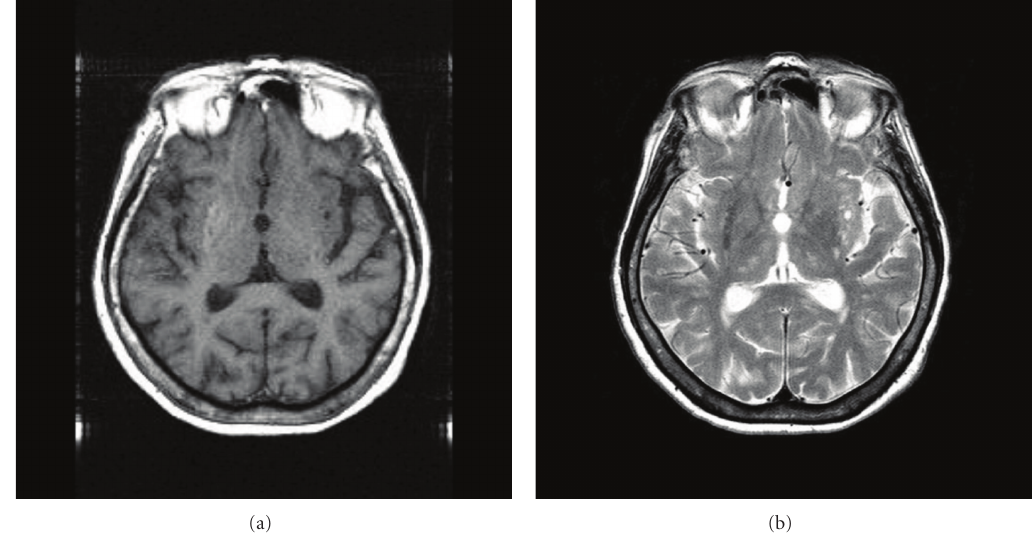
Figure 1: (a) MRI scan showing a hyperintense lesion on T1-weighted image. Arrow corresponds to the right striatum. (b) MRI scan showing a low signal intensity on T2-weighted